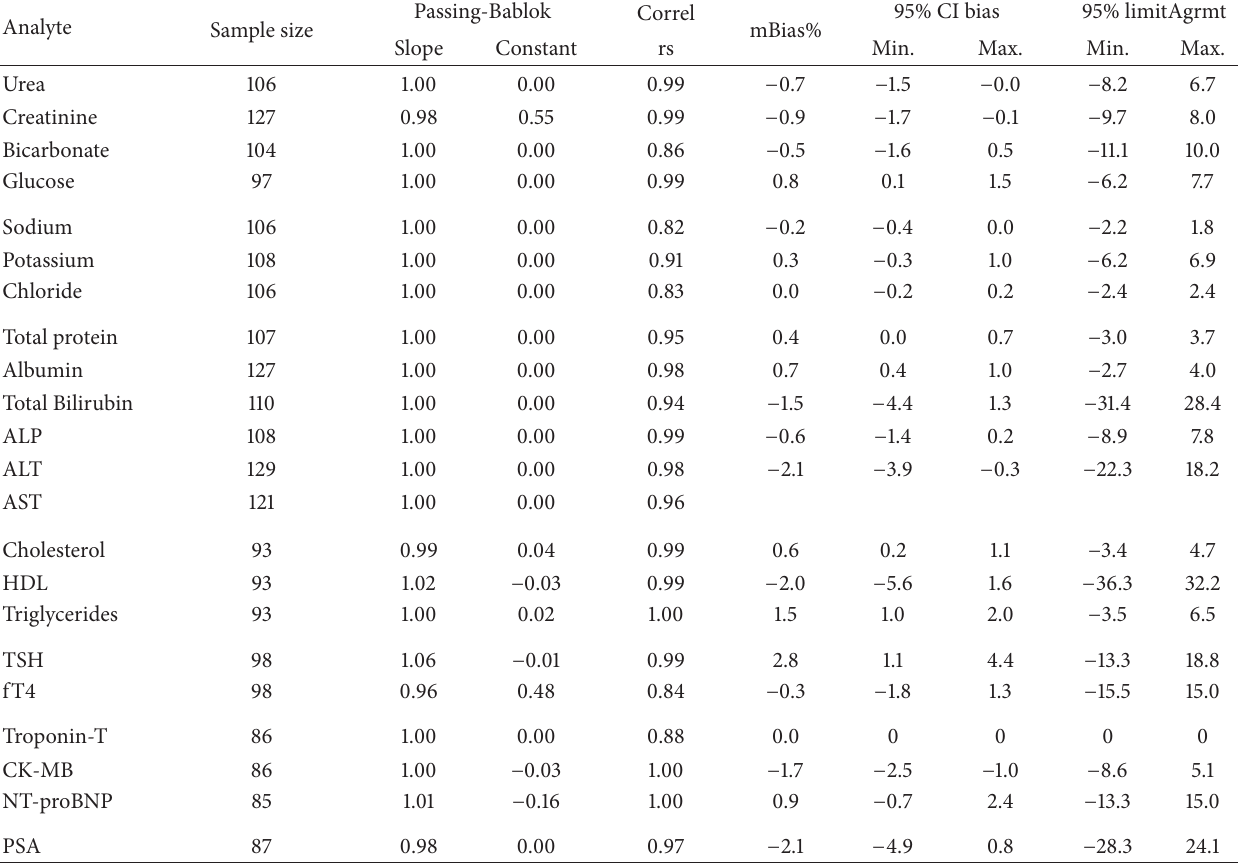
Table 3: Summary of Passing-Bablok regression and Bland-Altman bias between RST and